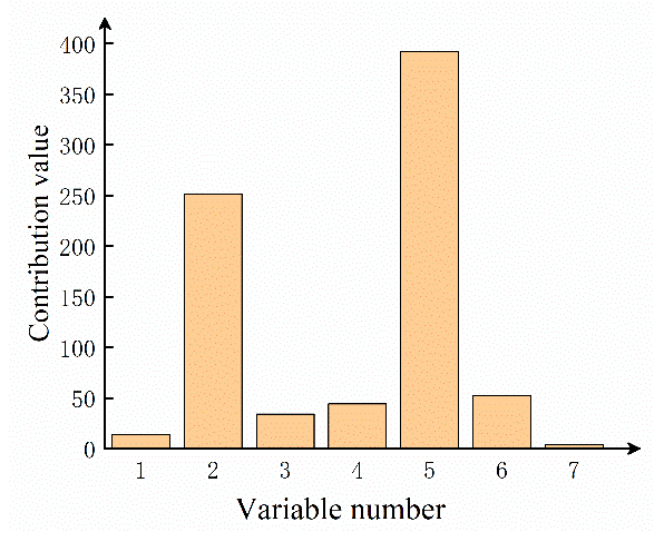
Figure 16. Traditional contribution plot of sample 1.